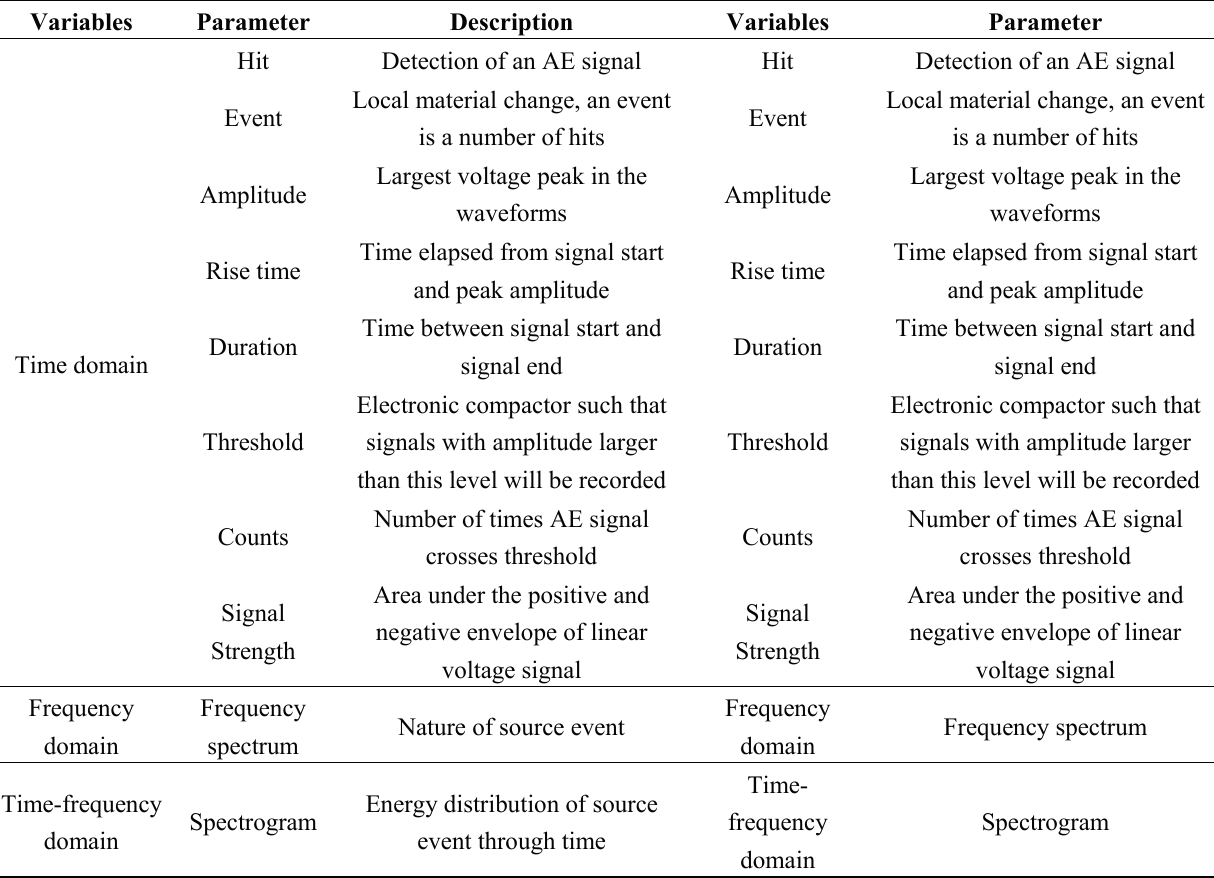
Table 3. AE parameters and the applications in source events information (Reproduced and modified from